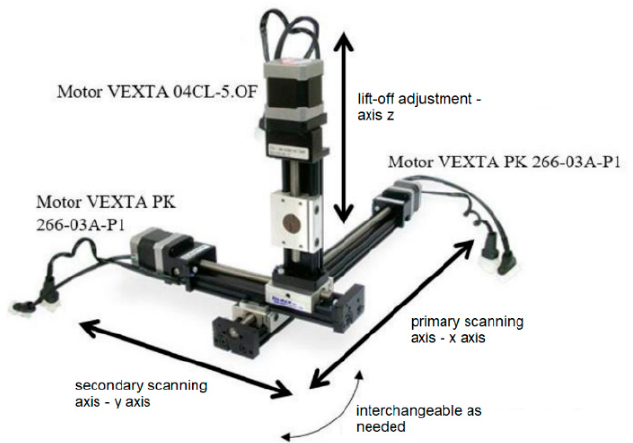
Figure 3. 3-axis independent linear positioning device with step motors.